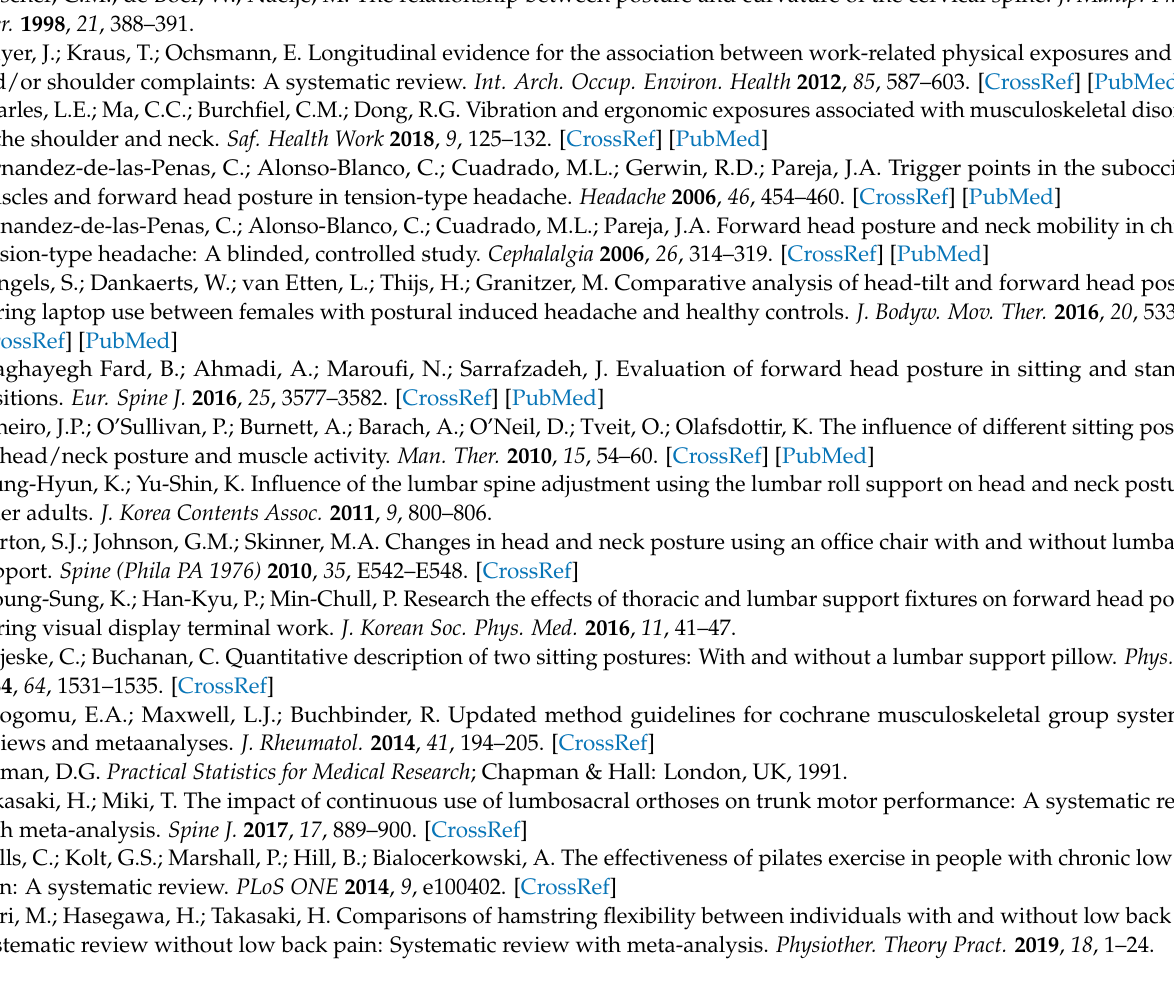
Table S2: List of the 31 included studies in the full-text